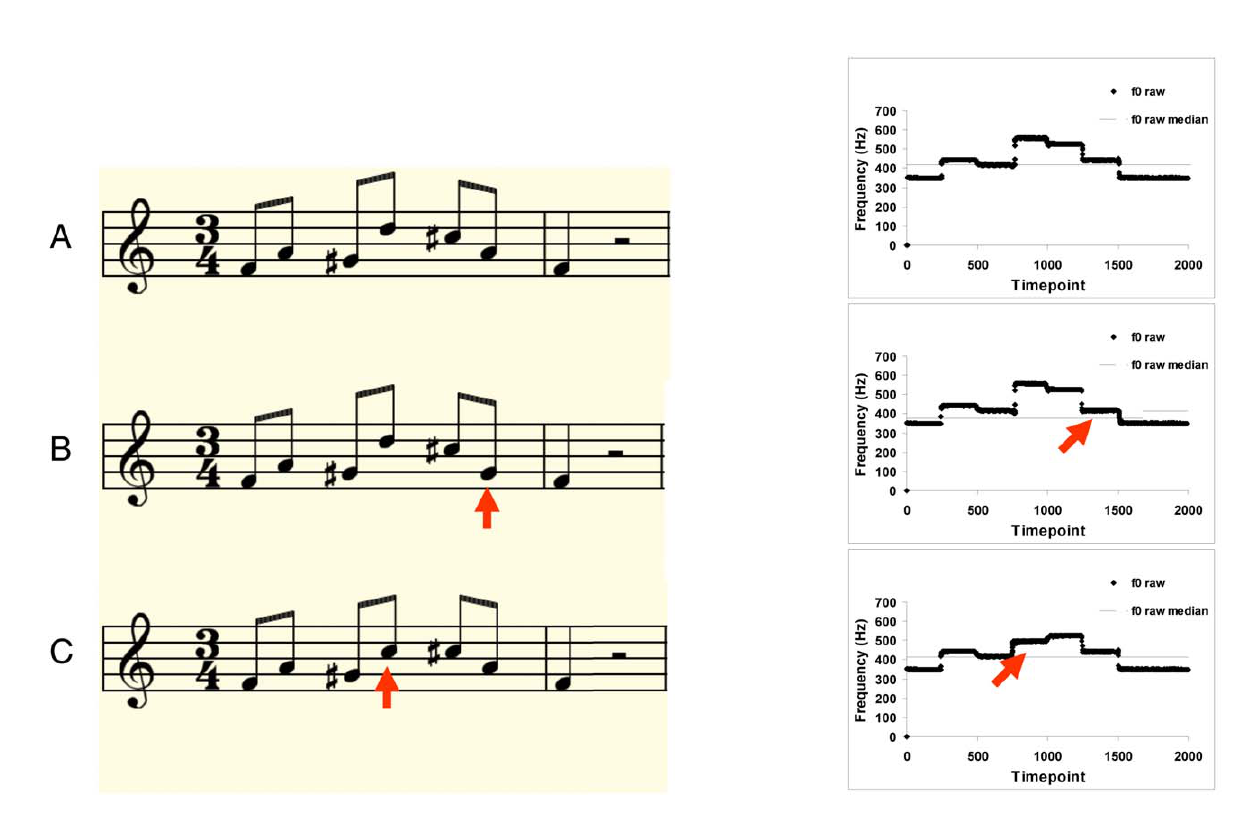
Figure 3. Three melodies in musical notation (left) and their corresponding fundamental frequency contours (right). Melodies B and C are identical to Melody A, except for one changed tone (indicated by red arrows in both the musical notation and the pitch traces). Melodies A and B have the same contour (up, down, up, down, down, down), whereas Melody C has a different contour (up, down, up, up, down, down). The associated sound files illustrate that Melody C (Sound S9) is generally more easily distinguished from Melody A (Sound S7) because of this contour change, whereas Melody B (Sound S8) sounds more similar to Melody A because it has the same contour.